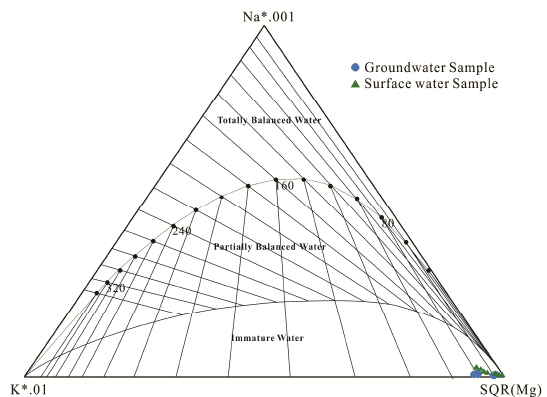
Figure 5. Na–K–Mg triangular diagram of water sample.